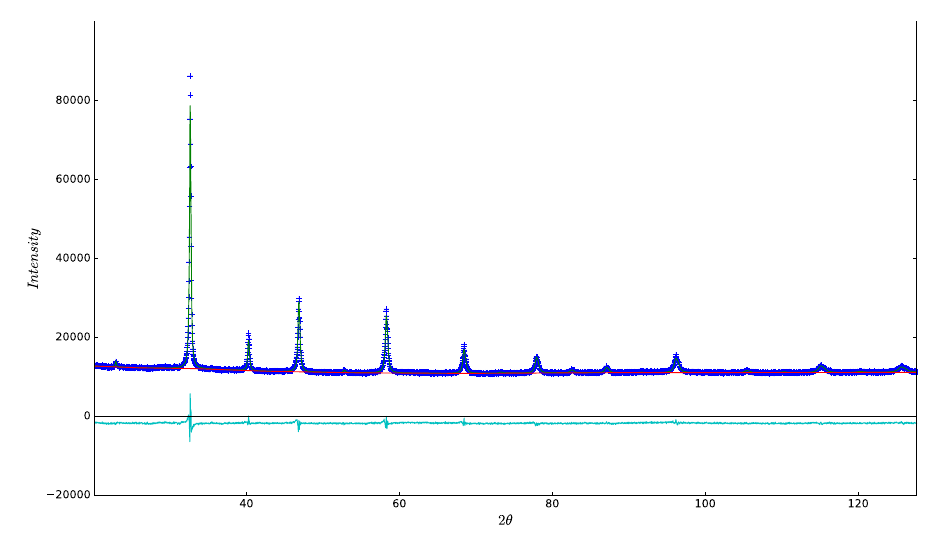
Figure 4. Observed, calculated and difference X-ray diffraction profile for SrFe 0.975 S 0.025 O 3- δ .